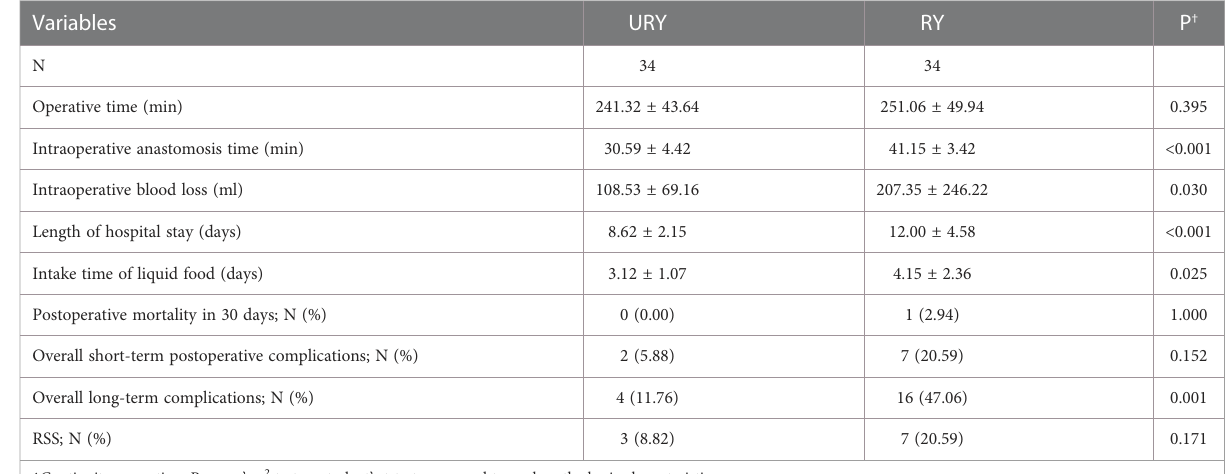
TABLE 5 Operation conditions and complications after